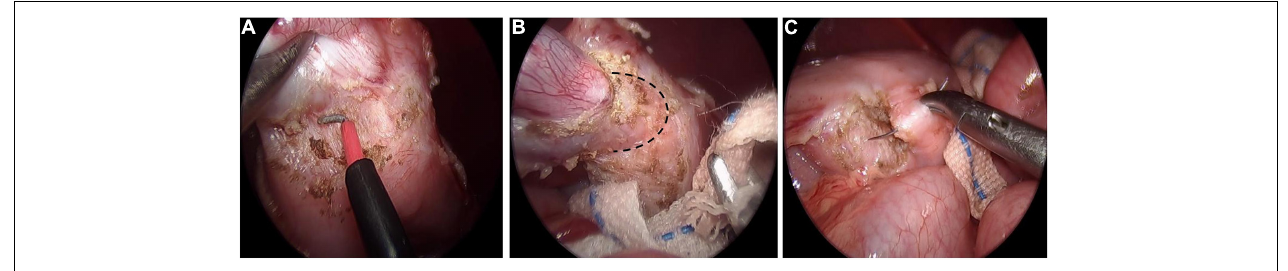
FIGURE 1 | Laparoscopic resection of gastric duplication. (A) Separation of GD by using electric hook. (B) Blunt dissection to locate the boundary (black dotted line) between the cyst and normal gastric wall muscle layer. (C) Repairing gastric wall muscle layer with intermittent suture.